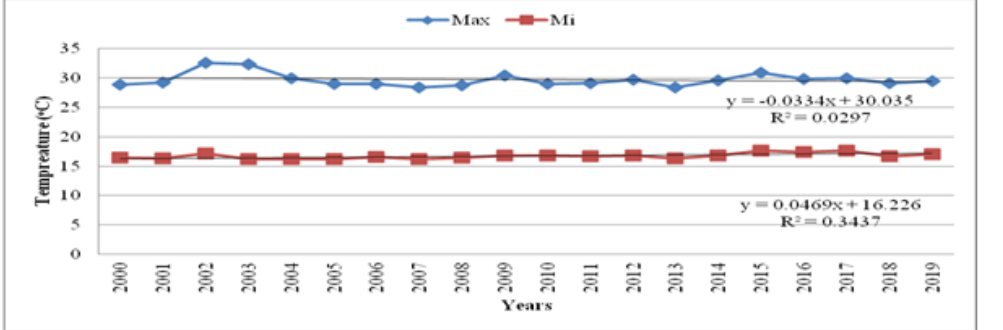
Source: National Meteorology Agency of Ethiopia (Hawassa branch)